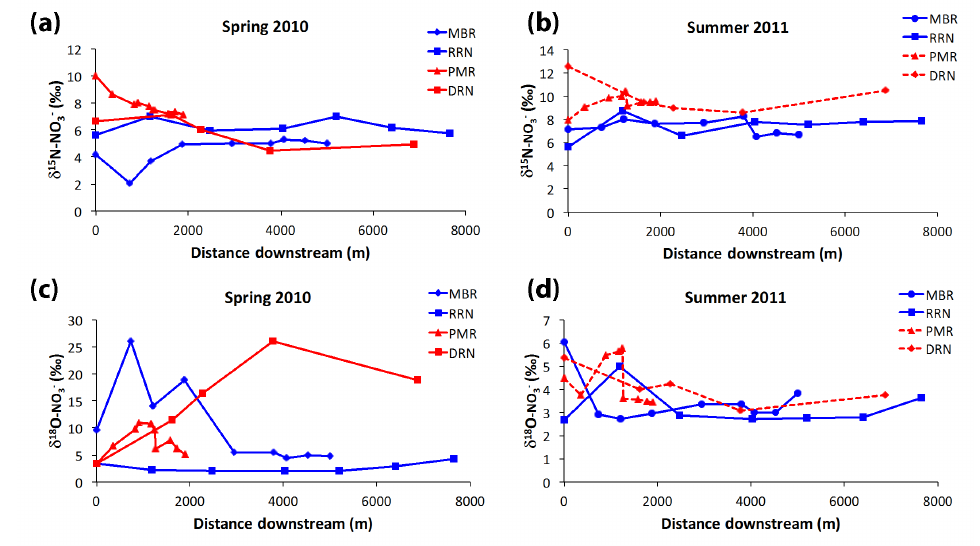
Figure 5. Longitudinal patterns in δ 15 N-NO −